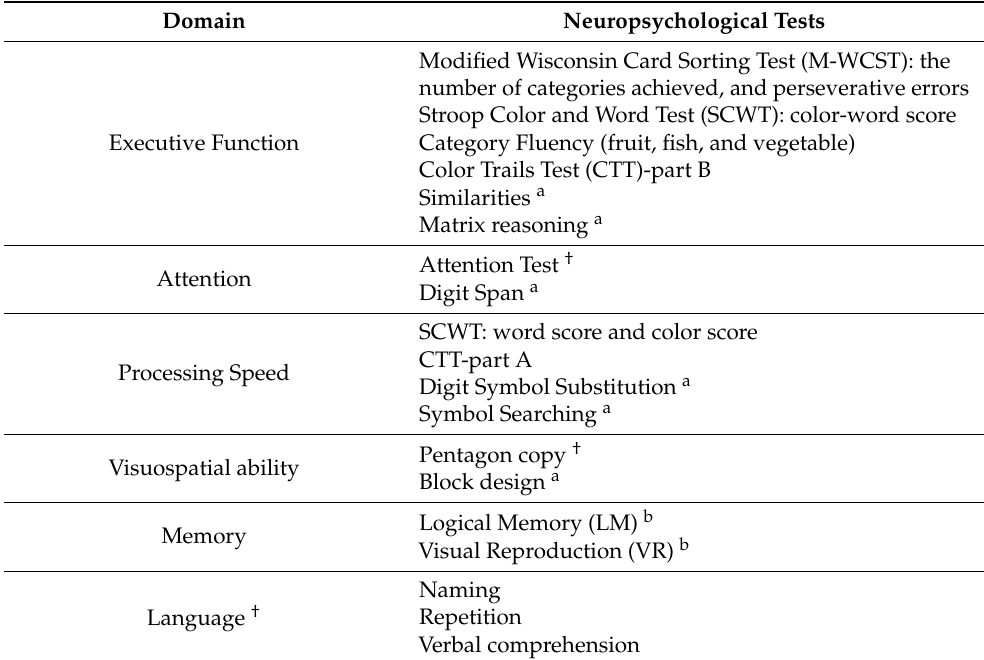
Table 1. The neuropsychological tests used in the current